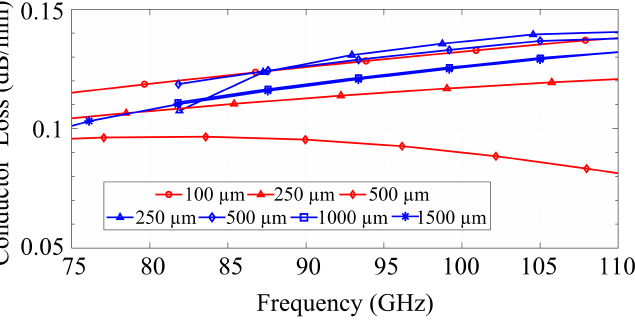
Figure 10. Comparison of conductor loss associated to a 2- µ m-thick metallization of copper with finite conductivity (58MS/m) in CB-CPW (red) and GapCPW(blue).